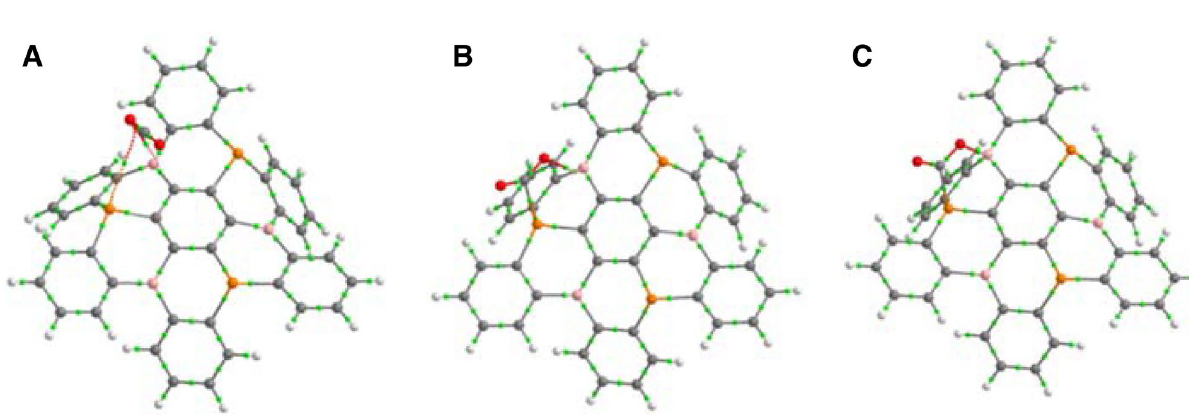
Figure 5. Molecular graph of the ( A ) (B 3 P 3 -NG):CO 2 , ( B ) (B 3 P 3 -NG)/CO 2 and ( C ) 1CO 2 -(B 3 P 3 -NG) of the first CO 2 capture by B 3 P 3 -NG. Bond critical points (BCP) are shown in